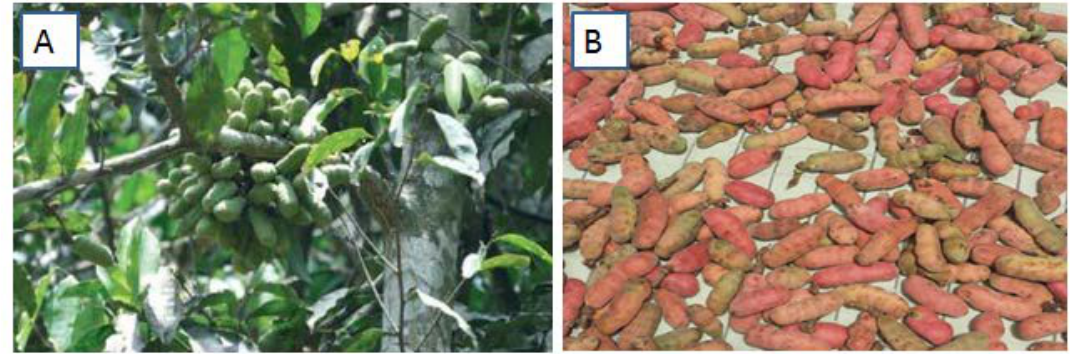
Figure 1. ( A ) Dennettia tripetala tree with leaves and unripe fruits. Image courtesy: World Agroforestry Center and Rubber Research Institute of Nigeria ( B ) Ripe (red) and unripe (green) Dennettia tripetala